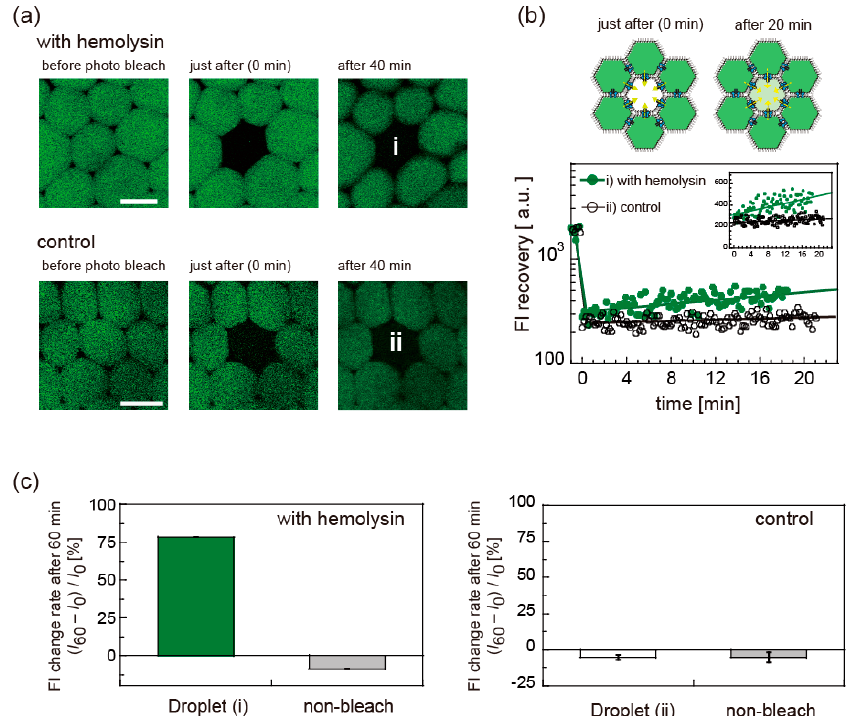
Figure 6. Fluorescence recovery after photobleaching (FRAP) experiments of adhered droplets containing water-soluble fluorescent solution (calcein, green) with or without hemolysin reconstituted into DIBs. ( a ) Confocal fluorescence images before and after photobleaching for DIB-bounded droplets with or without α -hemolysin (control). ( b ) (upper) Schematic of FRAP experiments where the droplet at center is photobleached. (lower) Fluorescence intensity (FI) change after photobleaching is shown as logarithmic scale and linear scale (inset). Solid lines are eye guides. ( c ) FI change rate within 60 min after photobleaching. ( I 60 − I 0 )/ I 0 where I 0 and I 60 are FI just after the photobleaching and after 60 min, derived from two different measurements is shown for photobleached droplets (droplets (i,ii) in Figure 6a) and non-photobleached droplets, respectively.